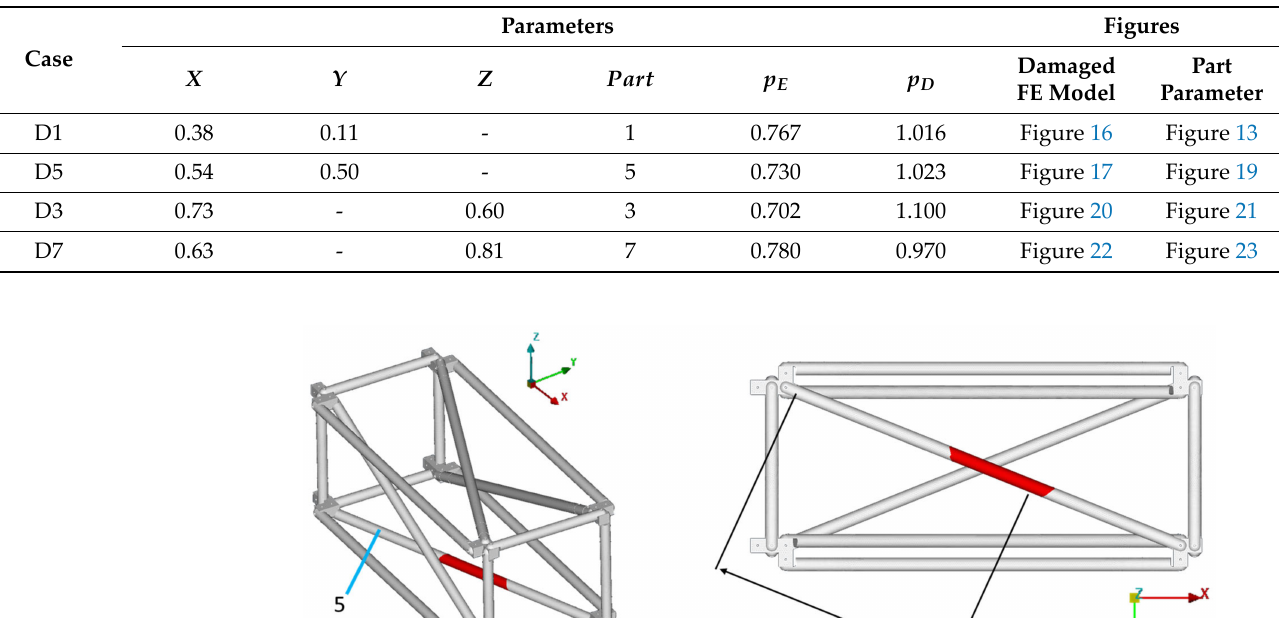
Table 3. Parameter results for each damage case.